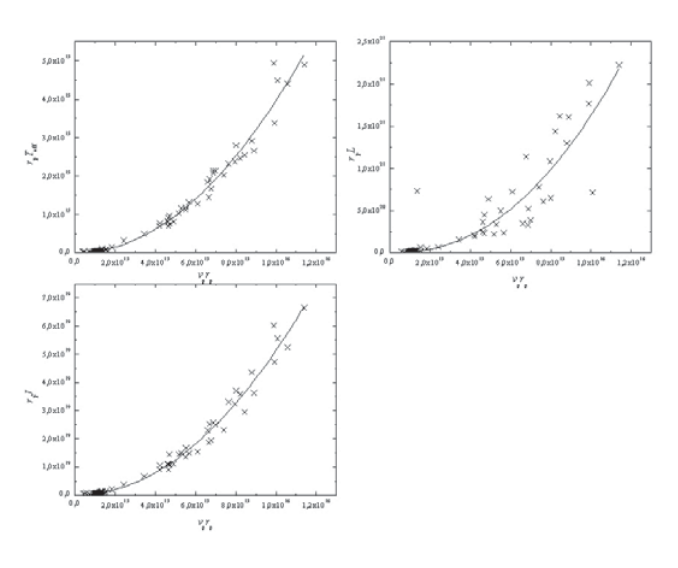
Fig. 1. Dependence of the parameters r p T e ff , r p L , and r p J on v p r p for the stellar spectral class F. According to the regression anal- ysis, the best is the power interpolation with the coe ffi cient of determination R 2 = 0 . 997 for the parameter r p T e ff .